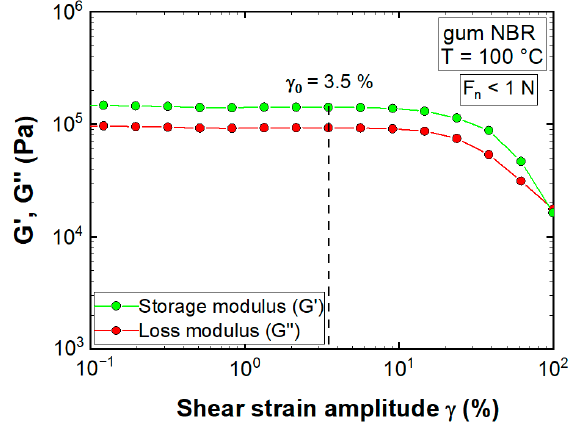
Figure A2. Exemplary amplitude sweep measurement performed with the MCR 501 device at 100 °C to detect the linear viscoelastic deformation range of gum NBR, with the selected shear strain rate of 3.5% for the frequency sweep measurements.